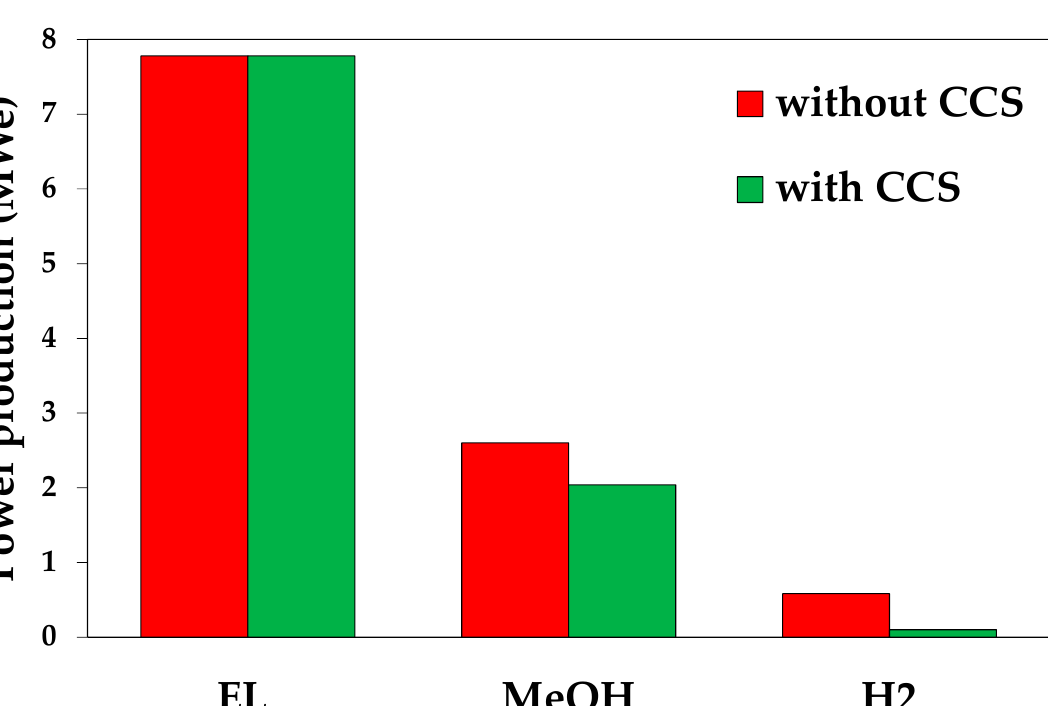
Table 5. Process simulation main results.